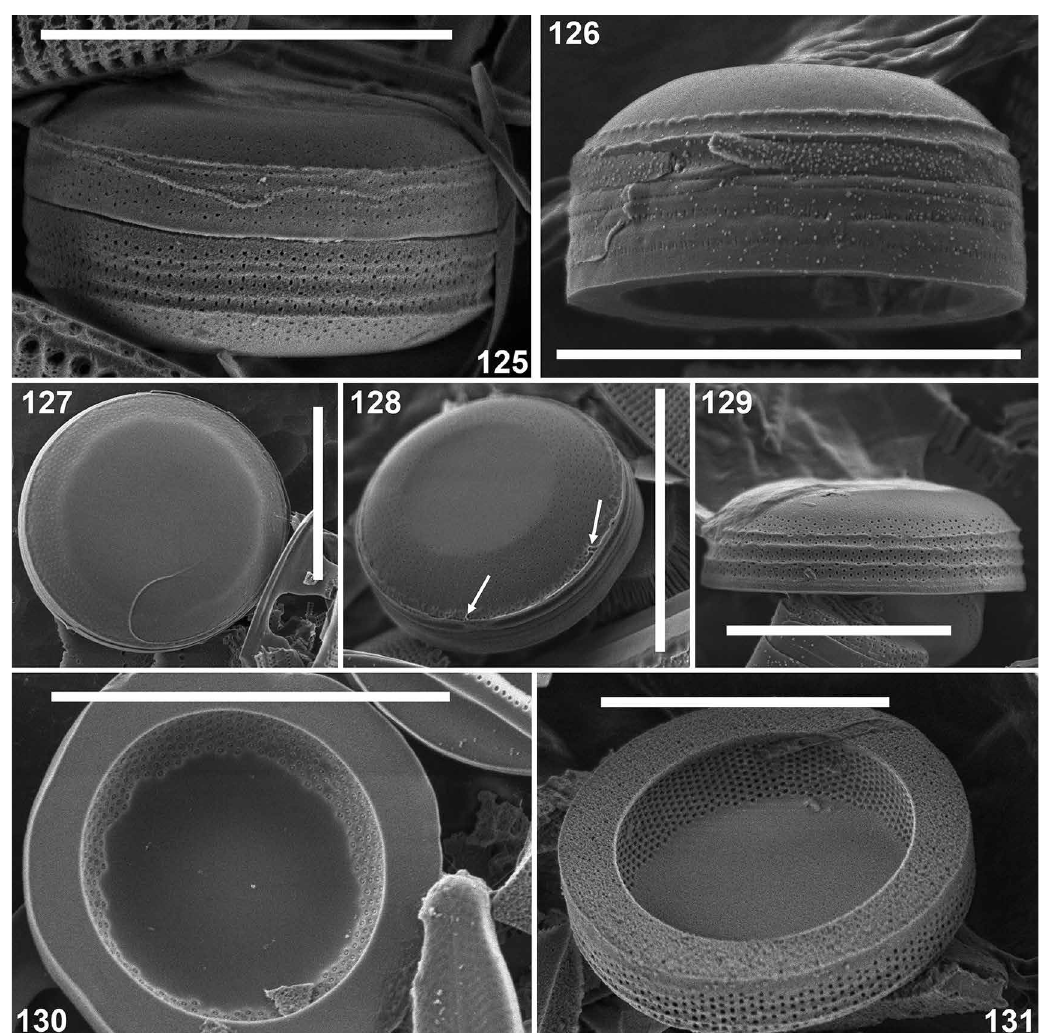
Figs 125–131. Arcanodiscus indistinctus Goeyers & Van de Vijver sp. nov. SEM. Campbell Island holotype population, sample BAS303 (BR-4580). 125 . Frustule in girdle view with eroded girdle showing the mantle with the parallel ridges. 126 . External view of a valve in girdle view showing the domed valve face, several marginal ridges and some of the narrow, unperforated copulae. 127–128 . External valve face view of an entire valve. Note the large central area and the striae on the sloping margin. On Fig. 128, note the siliceous outgrowth on the valve face margin. 129 . External view of a valve in girdle view showing the domed valve face, the distinct marginal ridges and the narrow mantle edge. 130–131 . Internal views of an entire valve showing the lack of rimoportulae. Scale bars = 10